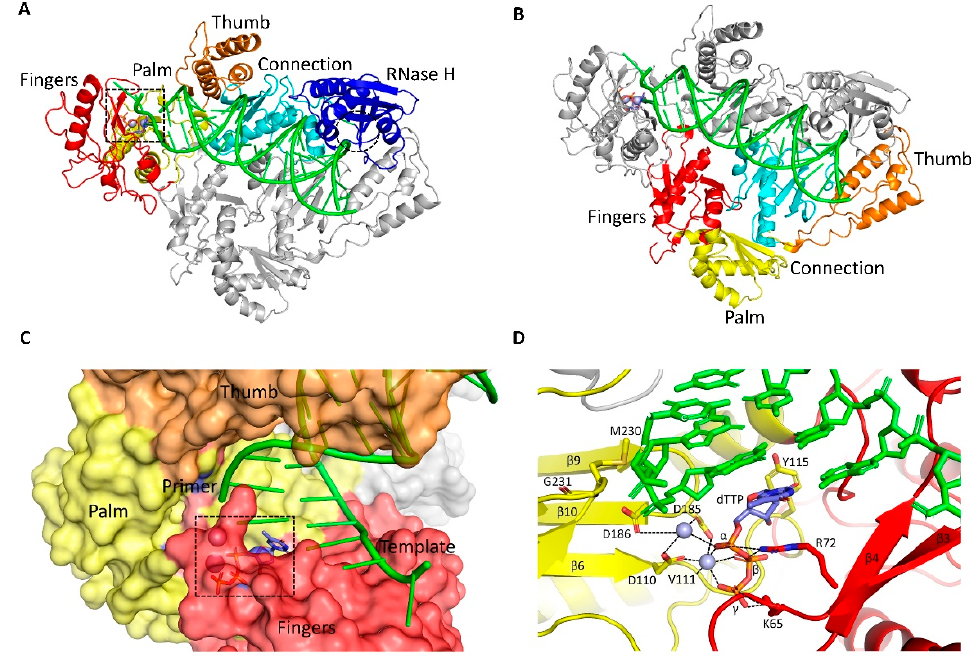
Figure 3. Binding of dNTP to HIV-1 RT. ( A ) Structure of RT in complex with a dsDNA, and dTTP bound at the polymerase active site (black dotted box; PDB ID = 1RTD [34]). The dsDNA is in green, dTTP as the blue stick model, and RNase H active site is highlighted as the dotted circle. The p66 (red, fingers; yellow, palm; brown, thumb; cyan, connection; and blue, RNase H) and p51 (gray) subunits constitute the hetero-dimeric RT. The template/primer in a cleft extends from the polymerase active site to the RNase H active site. ( B ) Different spatial arrangement of the subdomains in p51 (red, fingers; yellow, palm; brown, thumb; and cyan, connection) as compared to that in p66 ( A ); p66 is in gray. ( C ) A surface view of the dNTP-binding pocket highlighting the key p66 subunits involved in the pocket formation. The bound dTTP in the pocket is highlighted by a black dotted box. ( D ) A zoomed view of the dNTP-binding site showing metal-chelation and other interactions of the bound dTTP. The dNTP-binding site is composed of residues from palm and fingers; some are conserved, and some mutate to confer NRTI resistance [34].